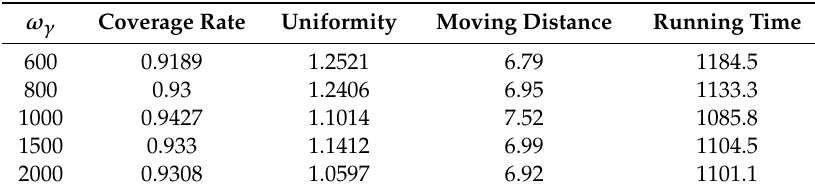
Table 1. Four indicators of the Virtual Force-L é vy-embedded Grey Wolf Optimization (VFLGWO) algorithm with di ff erent ω α